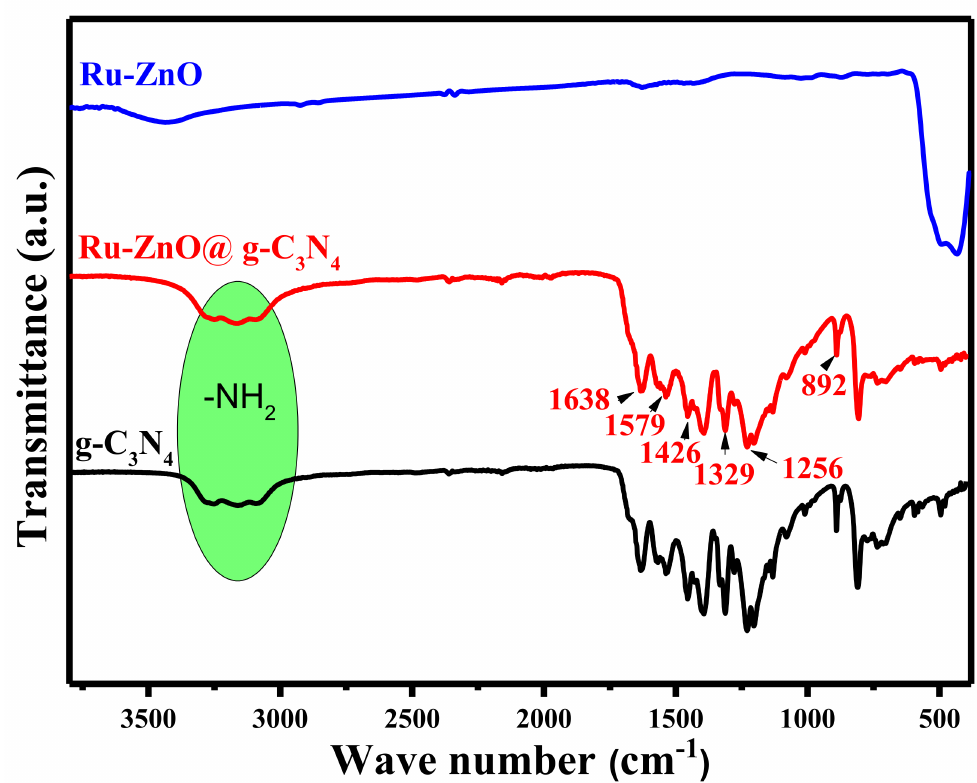
Figure 3. FTIR spectra of g-C 3 N 4 , Ru-ZnO, and Ru-ZnO@g-C 3 N 4